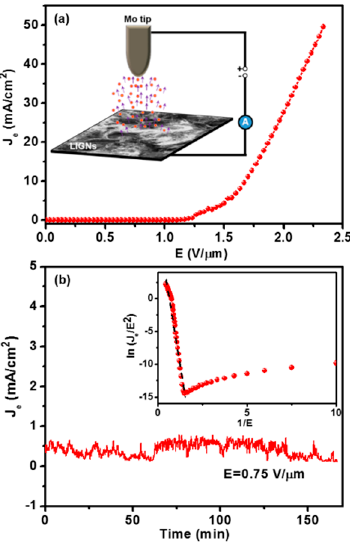
Figure 4. ( a ) Field electron emission properties (current density–applied field ( J e –E ) curves) measured in a high vacuum environment for LIGNs, with the inset showing the schematic of the FEE measurement. ( b ) Lifetime stability measurements ( J e –time curves) for LIGNs, with the inset showing the Fowler–Nordheim (F–N) plots corresponding to the J–E curves shown in ( a ).